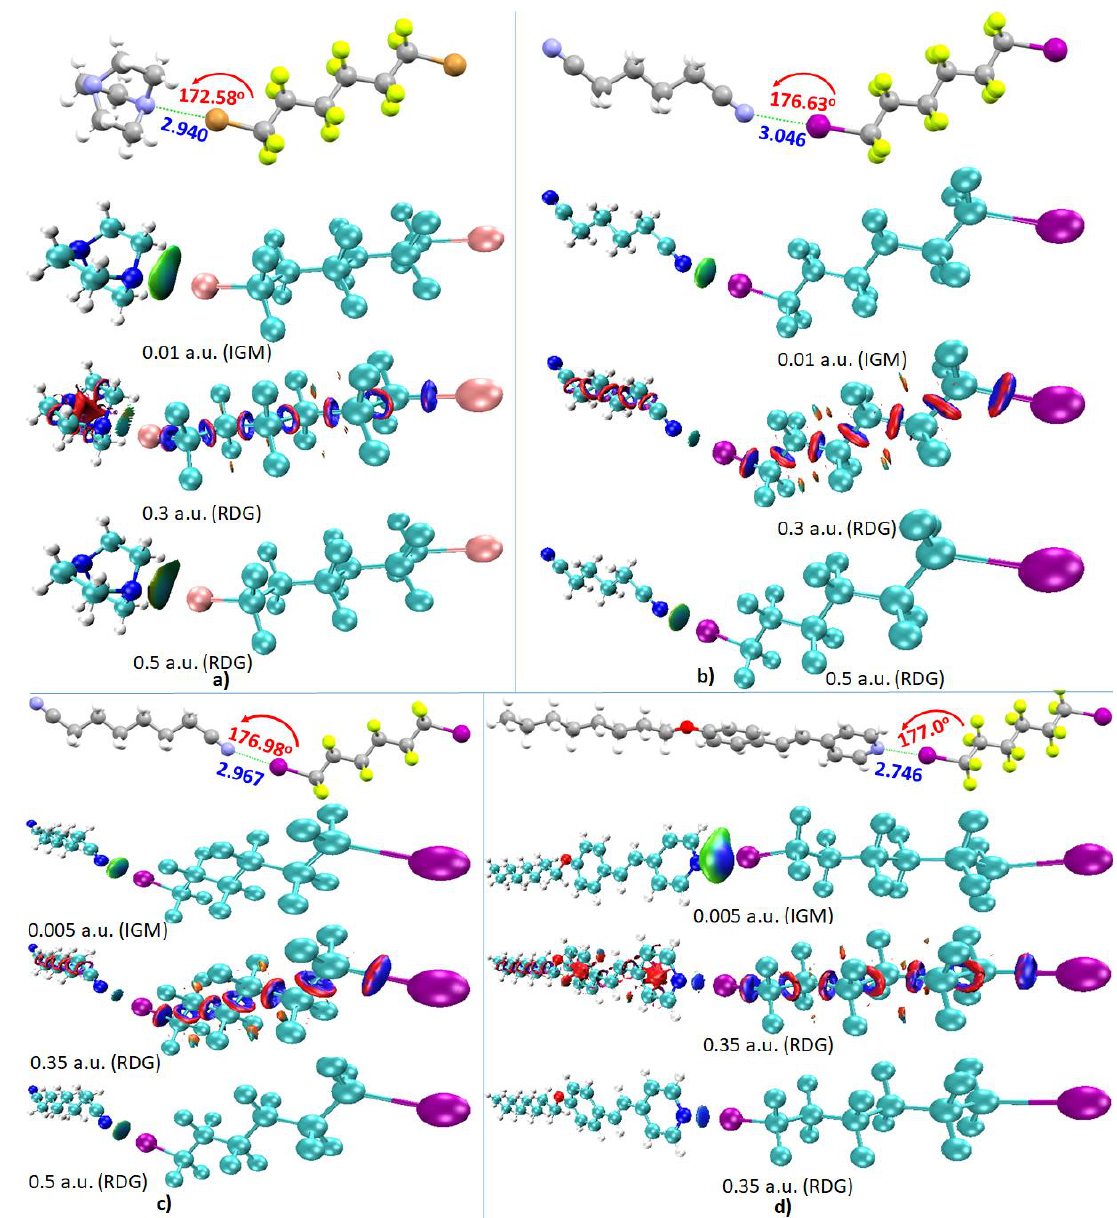
Figure 20. (First entry) Topology of Type-II halogen bonding in the crystal of ( a ) 1,4-diazabicyclo[2.2.2]octane 1,6-dibromo-1,1,2,2,3,3,4,4,5,5,6,6-dodecafluorohexane (CSD ref: CEMGEJ), ( b ) 1,4-Dicyanobutane 1,6-di-iodo-1,1,2,2,3,3,4,4,5,5,6,6-dodecafluorohexan (CSD ref: EBIJAB), ( c ) 1,6-Dicyanohexane 1,6-di-iodo-1,1,2,2,3,3,4,4,5,5,6,6-dodecafluorohexane (CSD ref: EBIJIJ), and ( d ) bis(4-(2-(4-pyridyl)ethenyl)-1-(octyloxy)benzene) 1,6-diiodo-1,1,2,2,3,3,4,4,5,5,6,6-dodecafluorohexane (CSD ref: DENMIT). Included in all cases are the isosurface plots emerged from promolecular IGM and Reduced Density Gradient (RDG) analyses: the second entry represents the IGM isosurface plot, the second entry represents the RDG isosurface plot, and the third entry represents the RDG isosurface plot; in which case only the N and I atoms were considered and the midpoint between them was defined as center. The blue and green parts of the isosurface are indicative of attraction, whereas the reddish part of the isosurface is a consequence of steric repulsion.